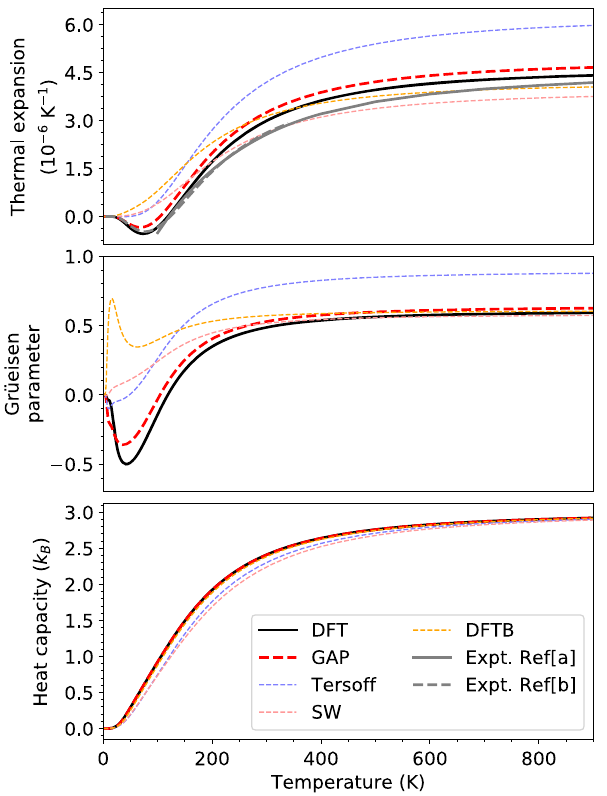
FIG. 20. Linear thermal expansion, Grüneisen parameter, and specific heat of silicon computed with various models, using the quasiharmonic approximation, compared to experimental results: (a) Lyon et al. [214] and (b) Okada and Tokumaru